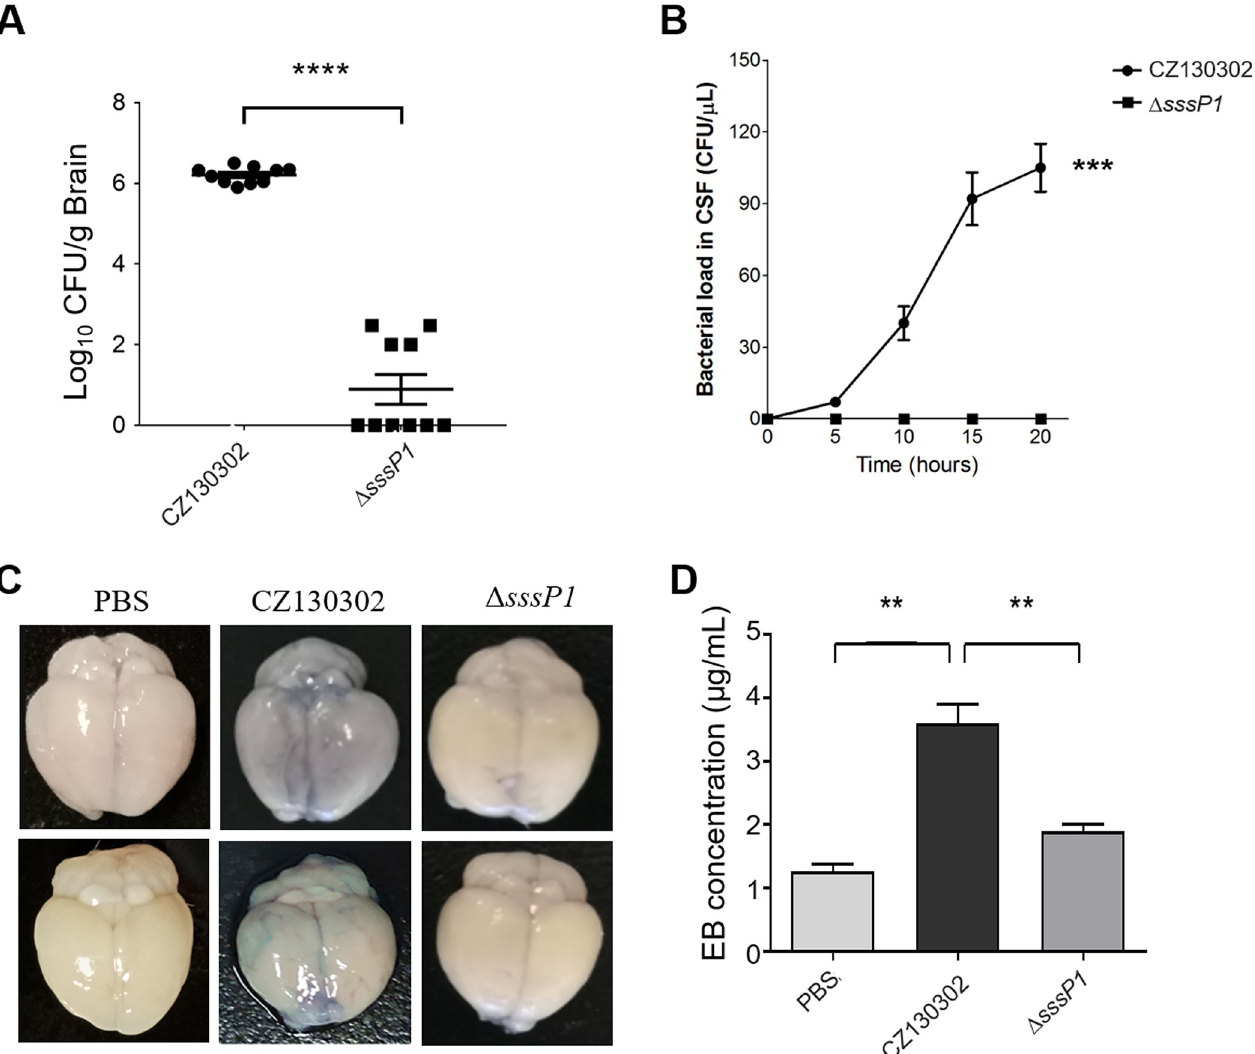
Fig 2. SssP1 is required for S . suis to cross the BBB in vivo . (A) The bacterial load of the wild-type and Δ sssP1 strains in the brain of the mice infected with the indicated strains. Data are represented as mean ± SEM of triplicate samples ( ���� P < 0.0001). (B) The curves showed the bacterial loads in CFS of the mice challenged with different S . suis strains until 20 h post-infection. Mean values and SEMs of triplicate samples are indicated. (C, D) Evans Blue (EB) permeability in brains of the mice infected with the indicated strains. EB concentration of the infected brains was measured. Data are represented as mean ± SEM of triplicate samples ( �� P <